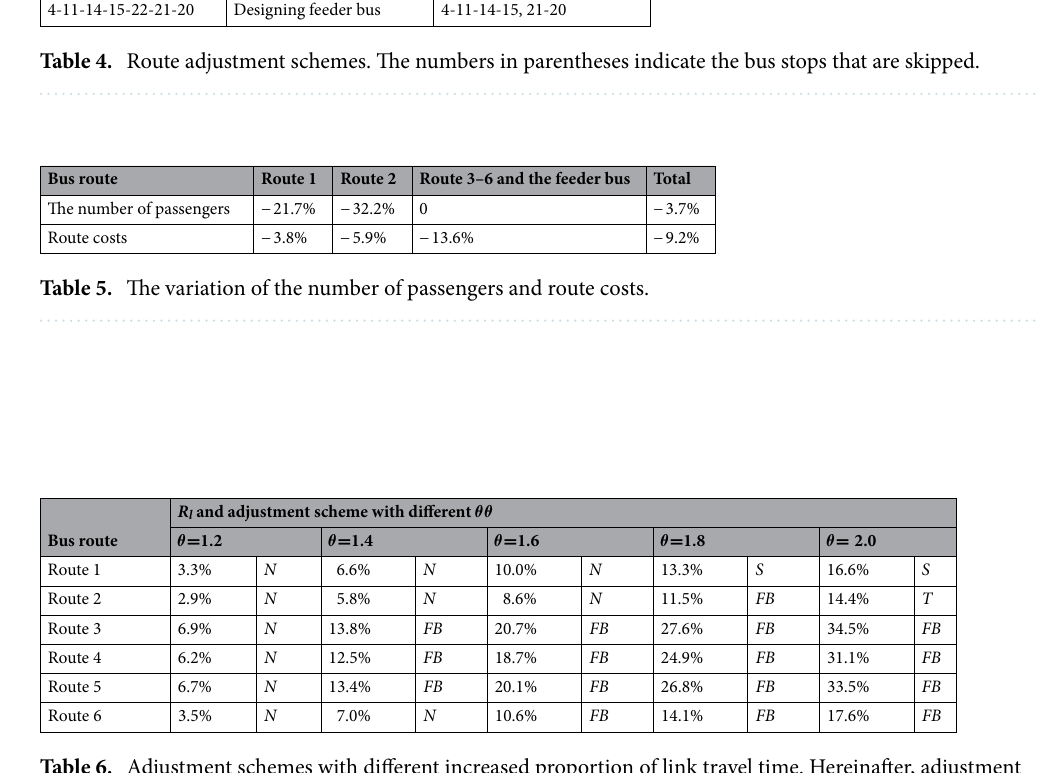
Table 6. Adjustment schemes with different increased proportion of link travel time. Hereinafter, adjustment scheme N represents the bus route does not need be adjusted. Adjustment schemes S , T , and FB represent the stop-skipping strategy, the truncation strategy, and the feeder bus service should be implemented, respectively.